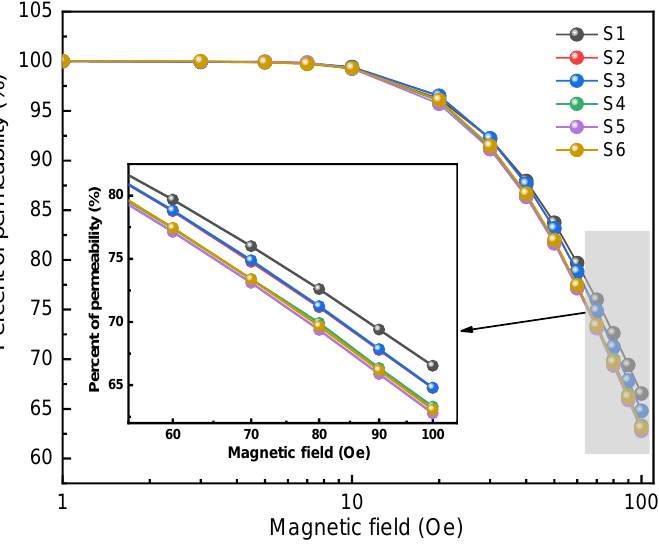
Figure 7. DC bias field dependence for SMPCs S1~S6 at magnetic field of 1~100 Oe. Figure 8a is the core loss versus frequency curve of SMPC samples. It can be found